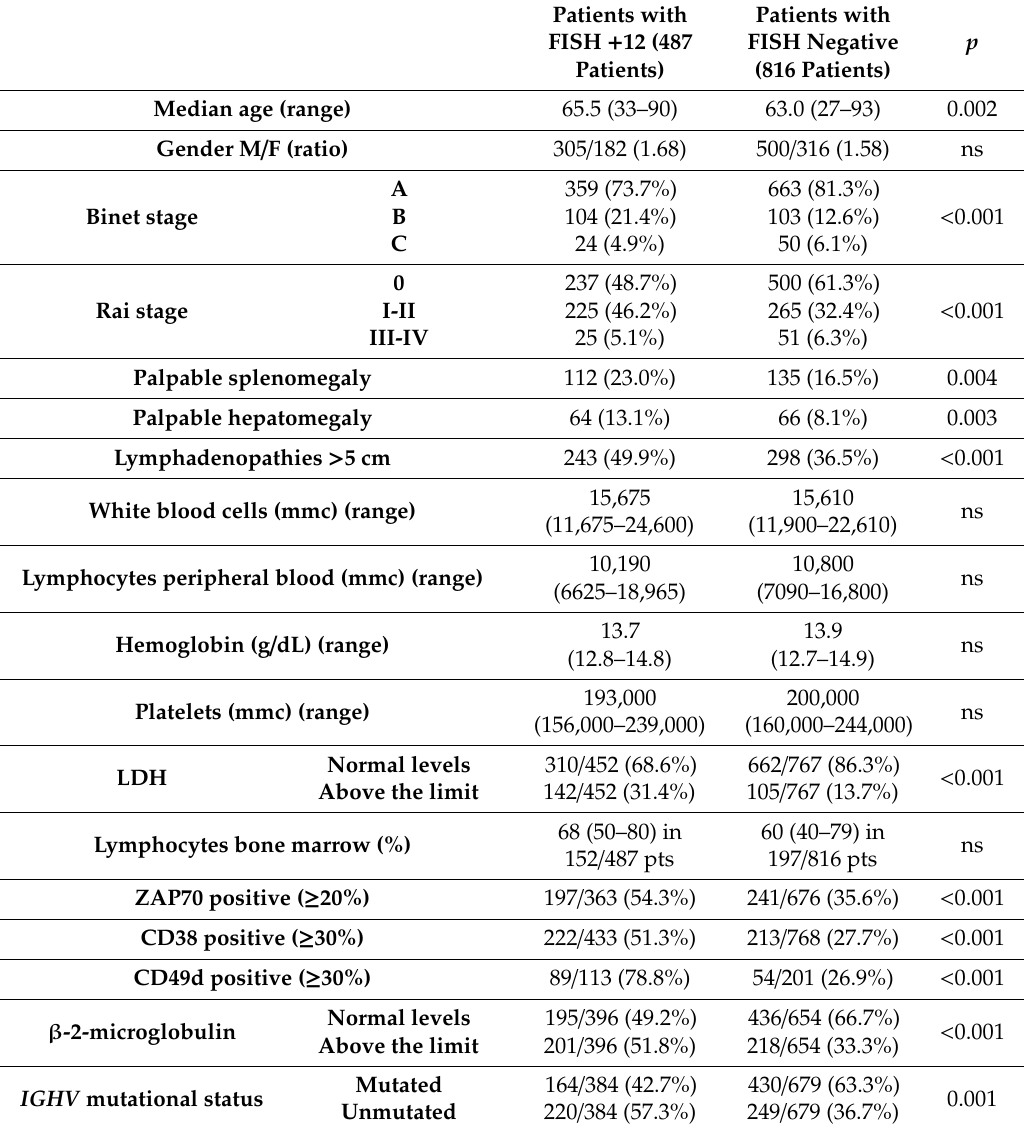
Table 1. Patients’ baseline characteristics at